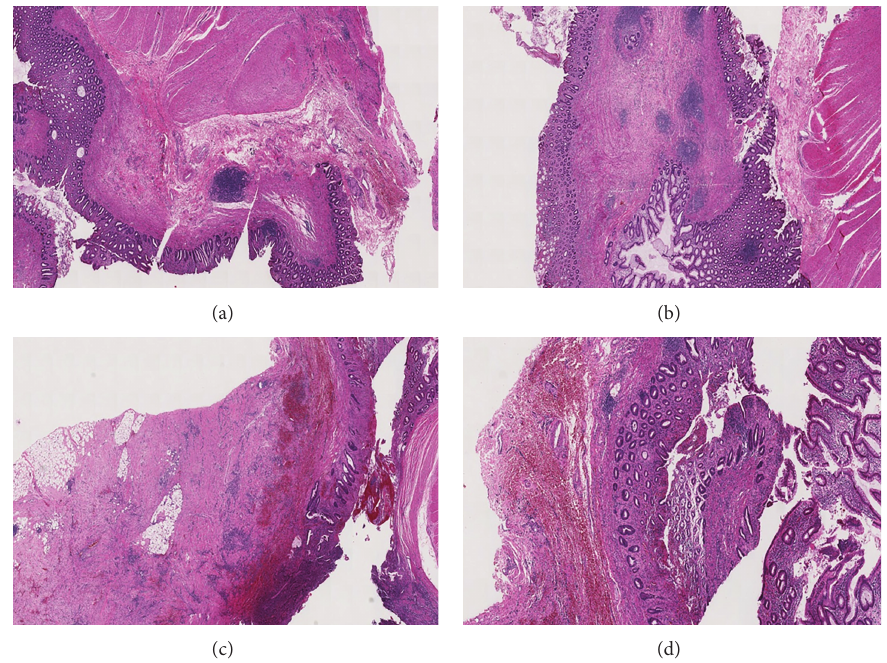
Figure 6: Microscopic view showing the ischaemic aspects and the presence of an hemorrhagic ulcer in the colonic